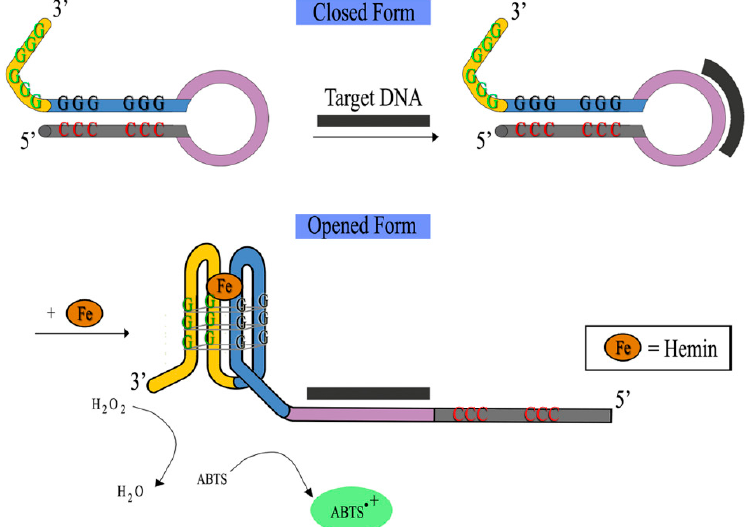
Figure 11. Typical DNAzyme-based colorimetric G-quadruplex/hemin-molecular beacon system.